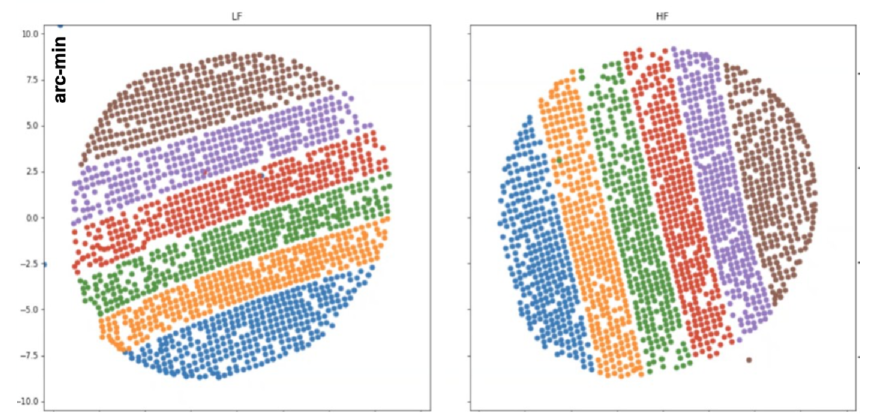
Figure 2. LF (left) and HF (right) focal plane geometries. Around 90% of the designed pixels exhibit a beam and are